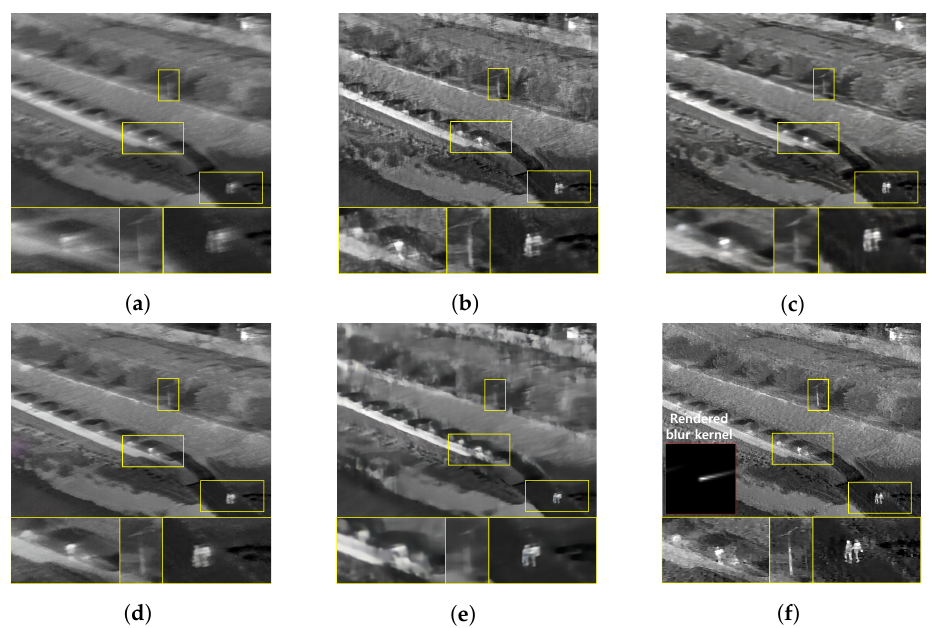
Figure 16. Qualitative comparison of motion deblurring results on the real blurry thermal